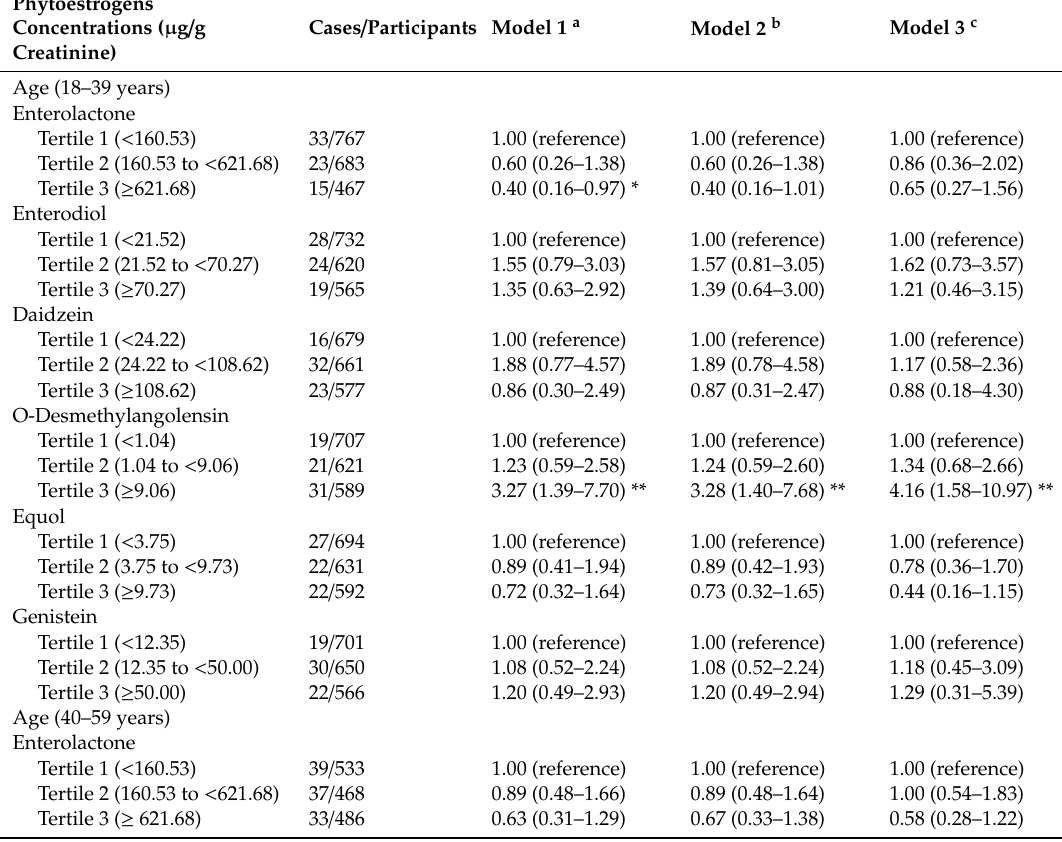
Table 3. Weighted odds ratios (95% confidence intervals) for sleep disorders across tertiles of urinary phytoestrogens concentrations stratified by age (National Health and Nutrition Examination